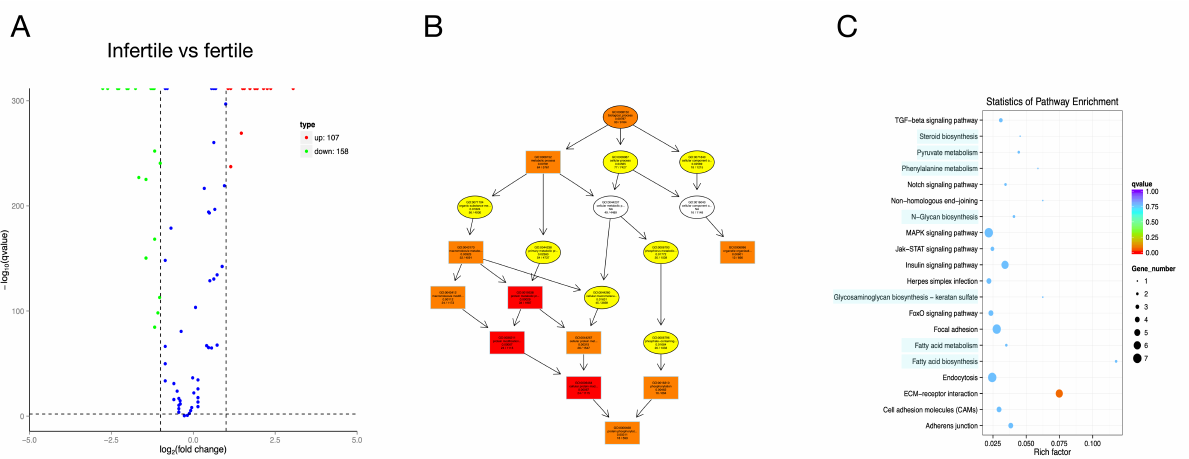
Figure 4. Volcano plot, Directed Acyclic Graph and pathway analysis scatter plot for target genes of DE circular RNAs (circRNAs) between infertile and fertile group in Paralichthys olivaceus . ( A ) Volcano plot for target genes of DE circRNAs. The red spots, green spots, and blue spots separately represent up-regulated, down-regulated, and undifferentiated target genes of DE circRNAs. ( B ) Top 10 changed GOs for target genes of DE circRNAs. ( C ) Top 20 changed pathways for target genes of DE